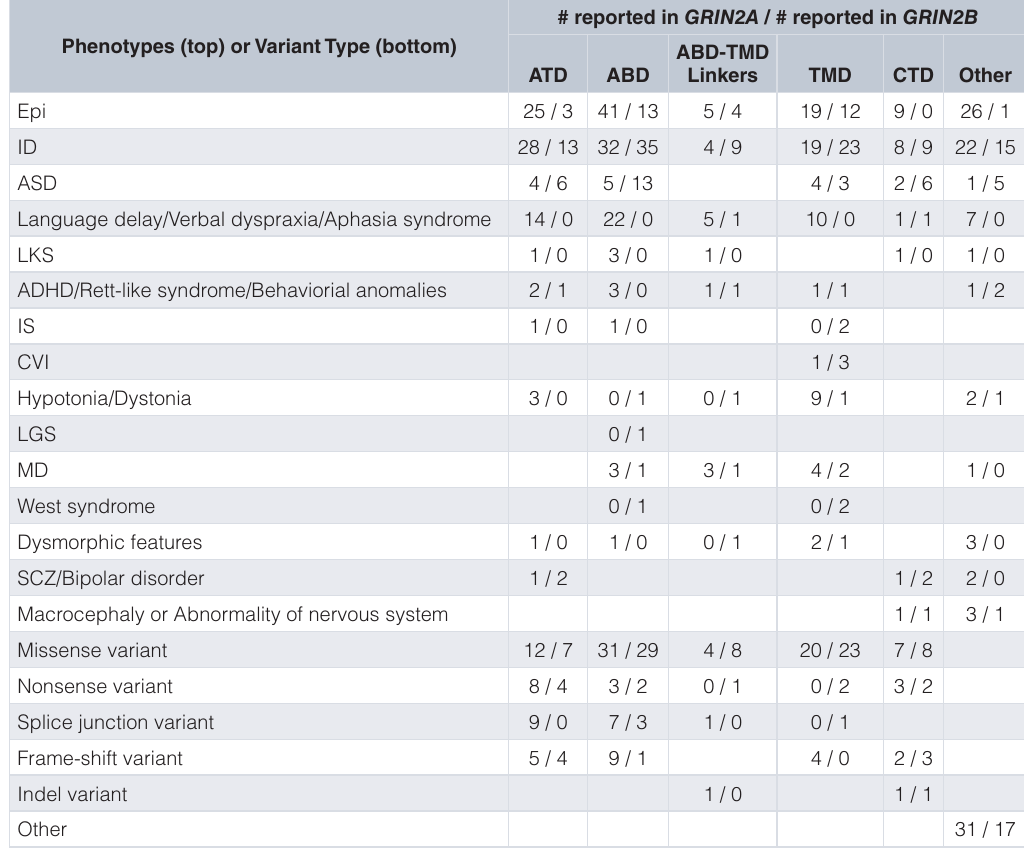
Table 1. Phenotypes reported across GRIN2A and GRIN2B